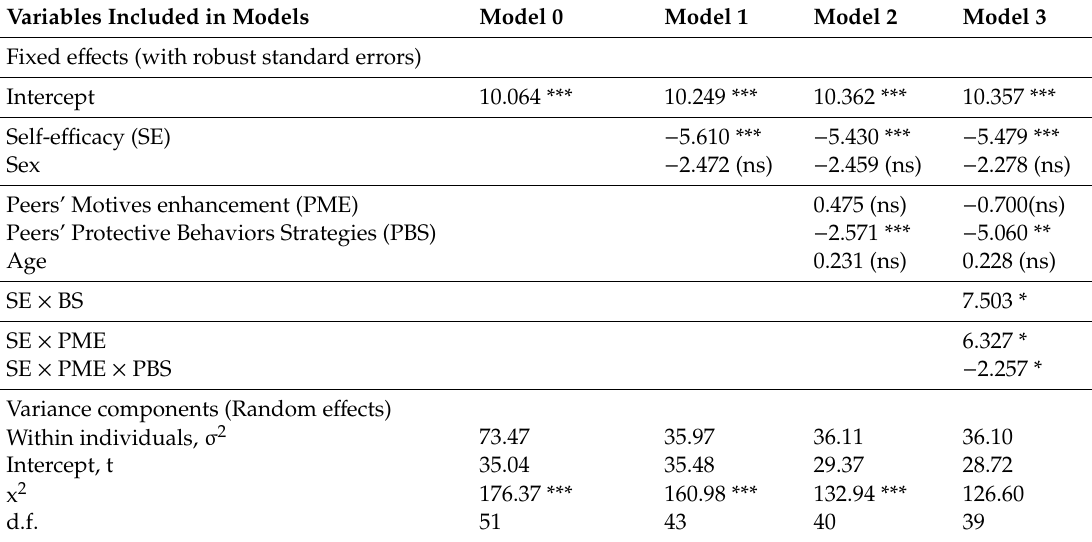
Table 1 summarized the multilevel regression models described below: Table 1. Results of the multilevel regression predicting individual lifestyle behaviors with alcohol